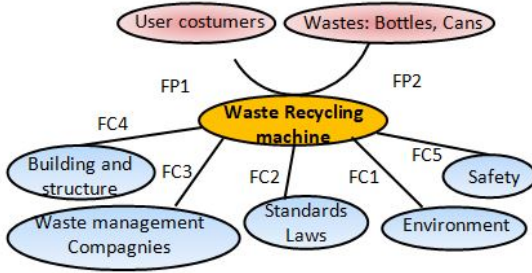
Figure 8. Octopus diagram of waste recycling